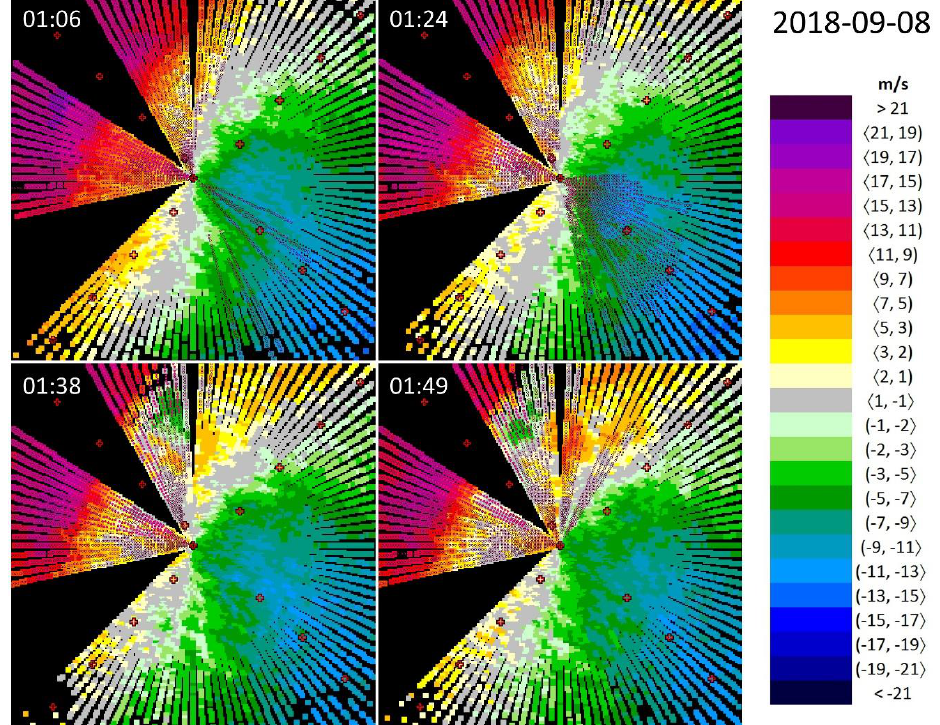
Figure 4. Wind shear in a temporally stable wind field between ~1:00 and ~2:00 AM UTC on 8 September 2018, seen by the lidar at the Bratislava Airport located at the center of each figure. Wind blowing towards the lidar is defined as positive. The empty (full) pink circles indicate wind shear condition (microburst condition) according to the ICAO thresholds.